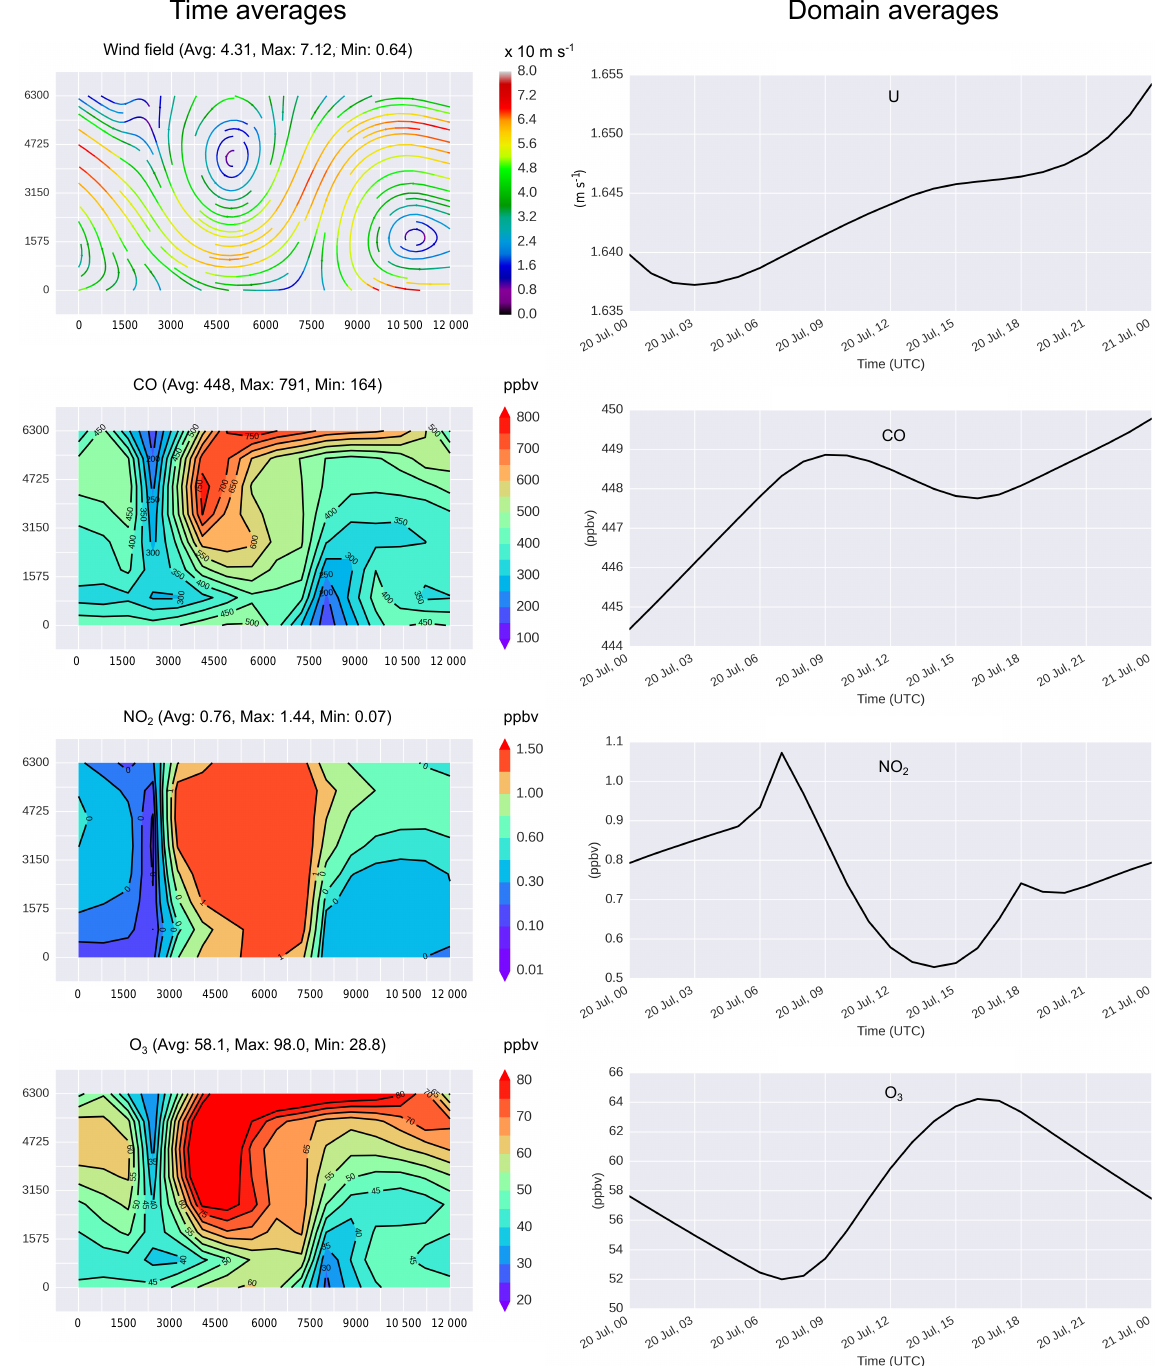
Figure 2. Meteorological and chemical fields of QG-Chem on day 20. Time-averaged fields for a 24h period on the left, time series of domain-averaged values for the same 24h period on the right. The wind field and the concentration of the four chemical species of interest (CO, NO 2 and O 3 , with CO 2 not shown since it is constant and equal to 310ppmv) are shown from top to